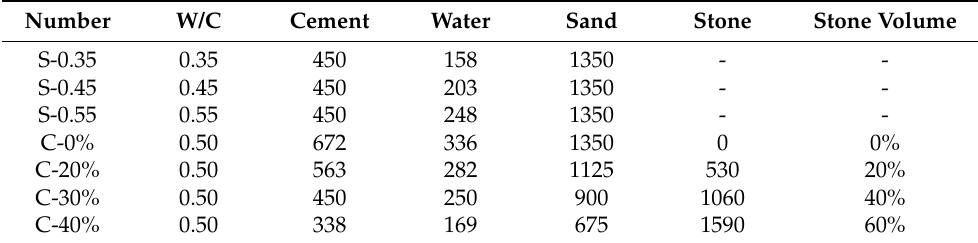
Table 3. Mix proportion design of mortar concrete (kg/m 3